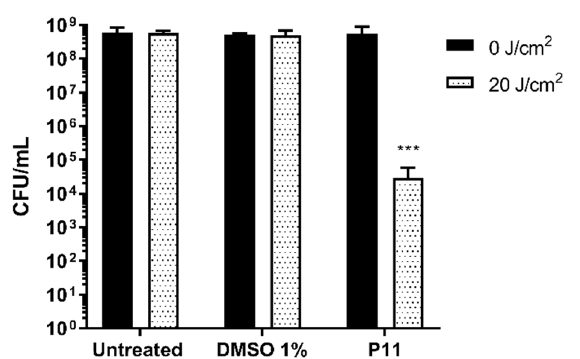
Figure 4. Photodynamic inactivation of P. aeruginosa PAO1 by P11. Bacterial samples at ~10 8 CFU/mL suspended in water were incubated in the dark for 1 h with P11 10 µM. After dark incubation, cells were irradiated under light at 410 nm (20 J/cm 2 ) and cellular viability was checked. Values, presented as CFU/mL, are the mean of at least three independent experiments and the bars represent standard deviations. Statistical analyses were performed by one-way ANOVA *** p < 0.0001).